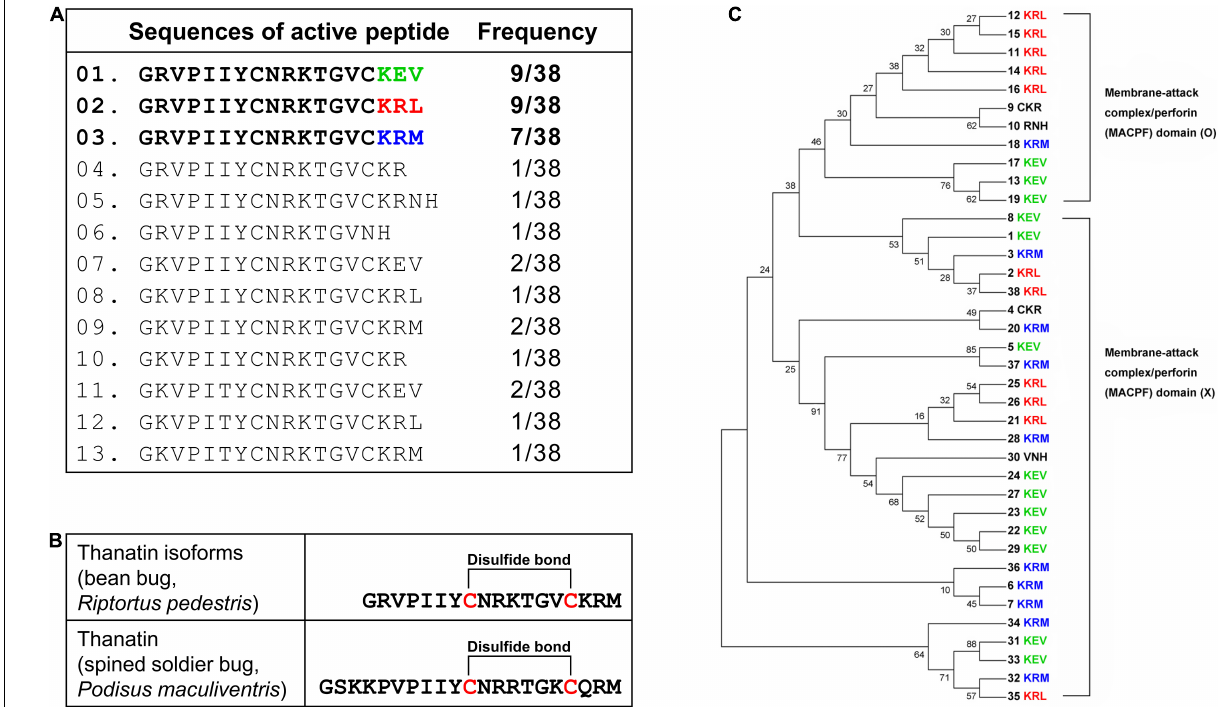
Frontiers in Microbiology |